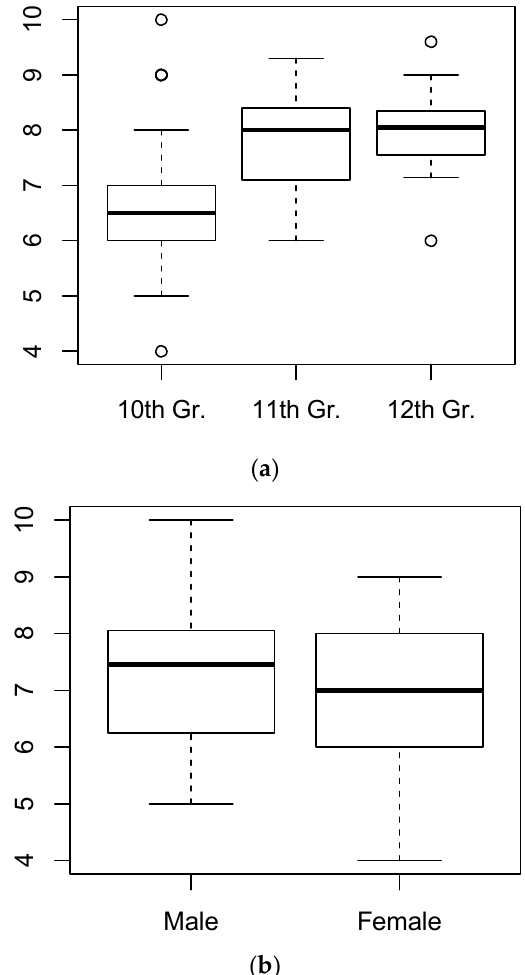
Figure 1. Distribution of the in the overall average grades obtained by the students that contributed to the study. ( a ) Grades of the students according the school level. ( b ) Grades of the students according gender.